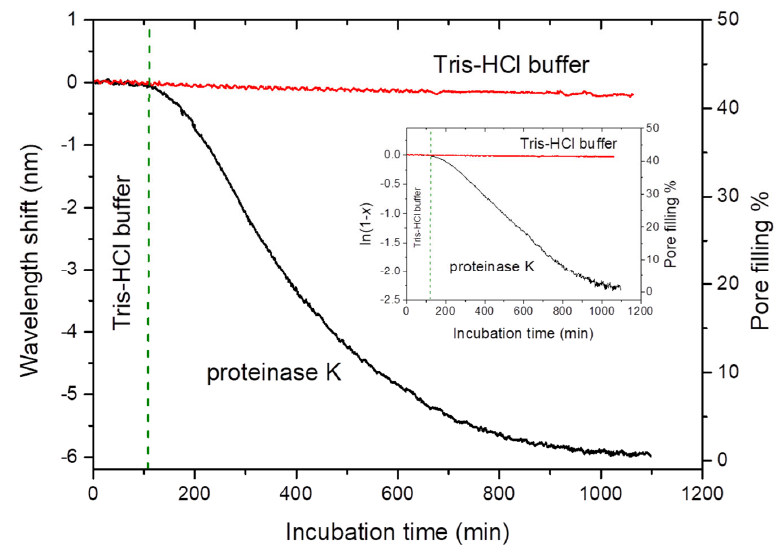
Figure 7. Plot of in situ RIfS measurement of enzymatic reaction in PLA modified pSiRF with proteinase K solution (1.00 mg mL − 1 ) and Tris-HCl buffer at 25 ◦ C.